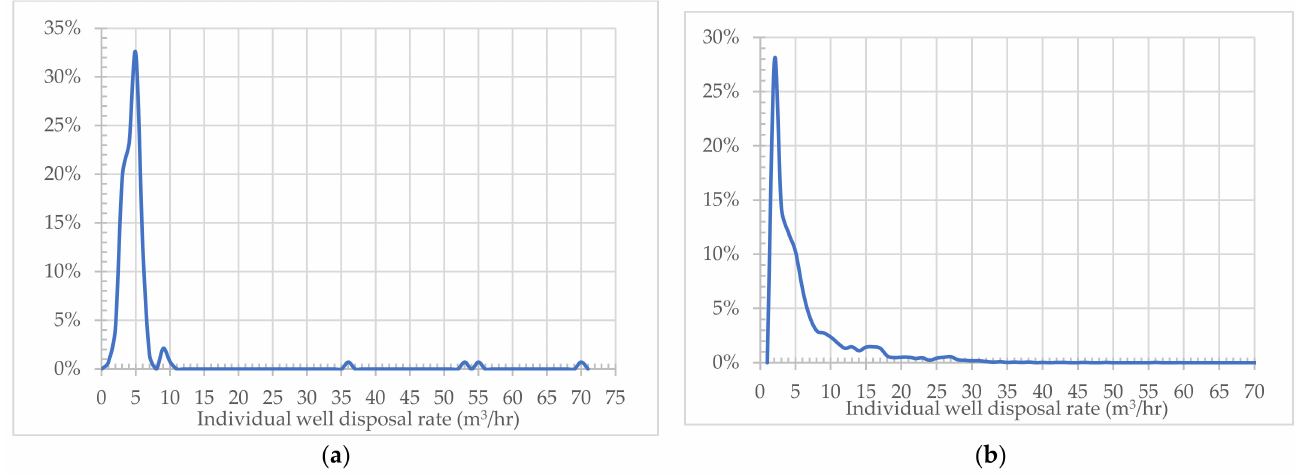
Figure A2. Historical per-well injection rate ( X -axis) frequency ( Y -axis) distributions (January 1962– December 2022) in ( a ) the Dunvegan Formation; ( b ) the Viking Formation.